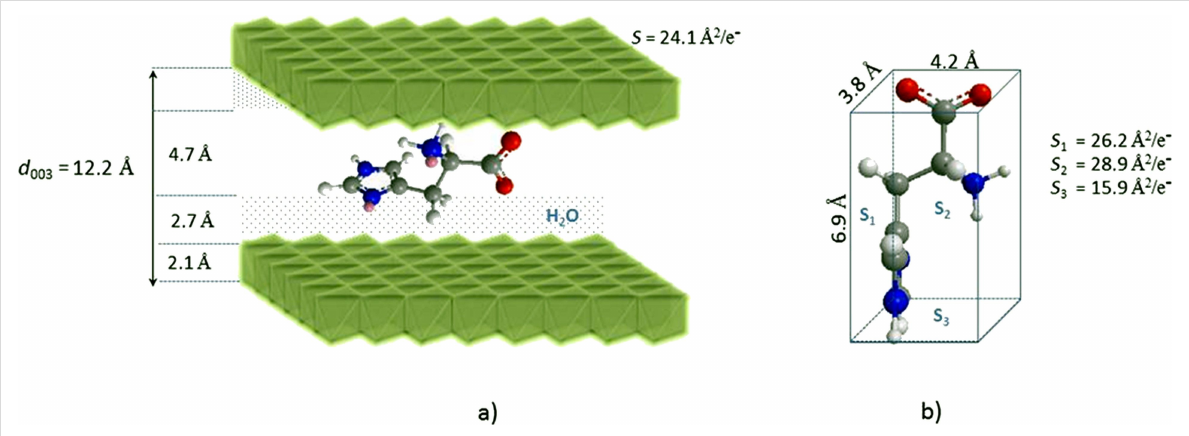
Figure 2: a) Structural model for Mg 2 Al/HIS, b) molecular structure of L-histidine, dimensions and corresponding surface area per unit charge calcu- lated by considering a rectangular parallelepiped shape.